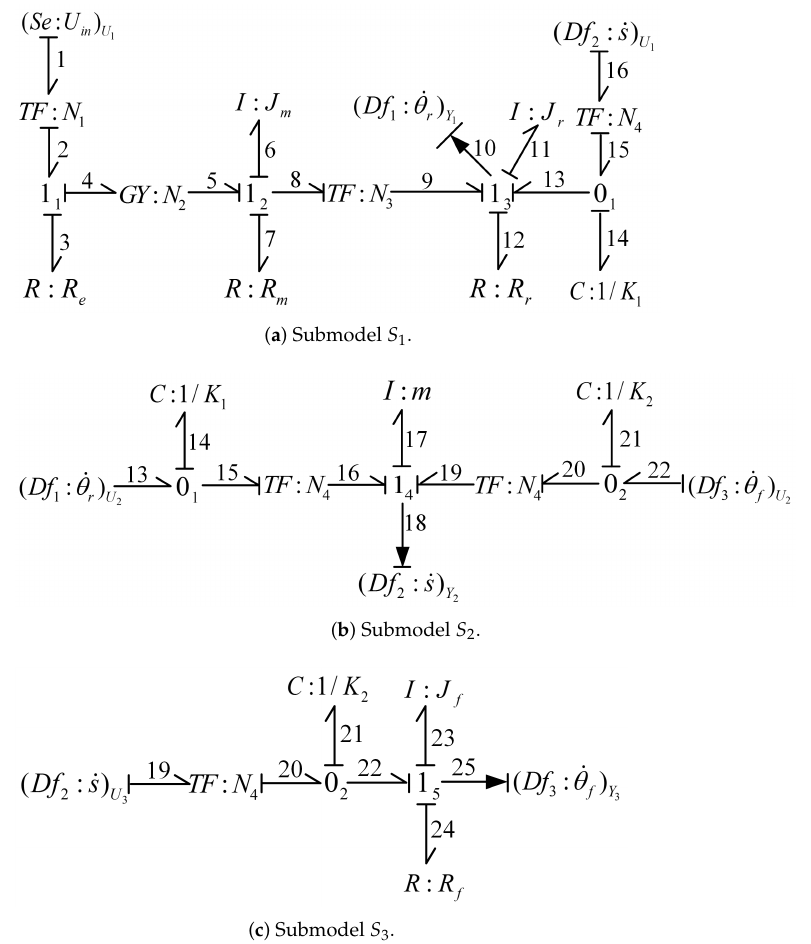
Figure 3. Submodels of electric